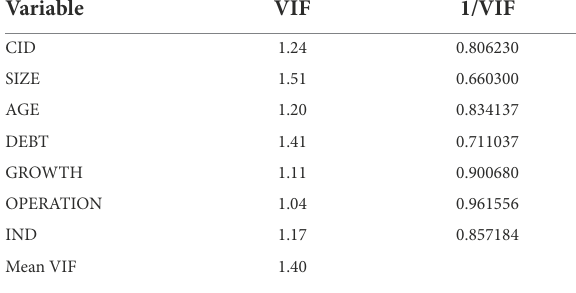
TABLE 11 Variance inflation factor test for